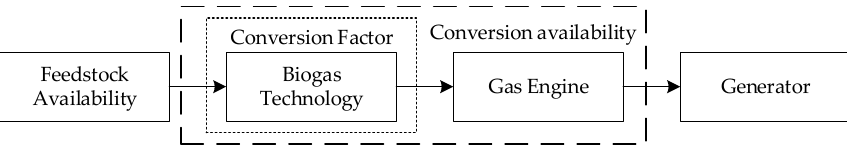
Figure 15. Basic operation model of biogas generation.